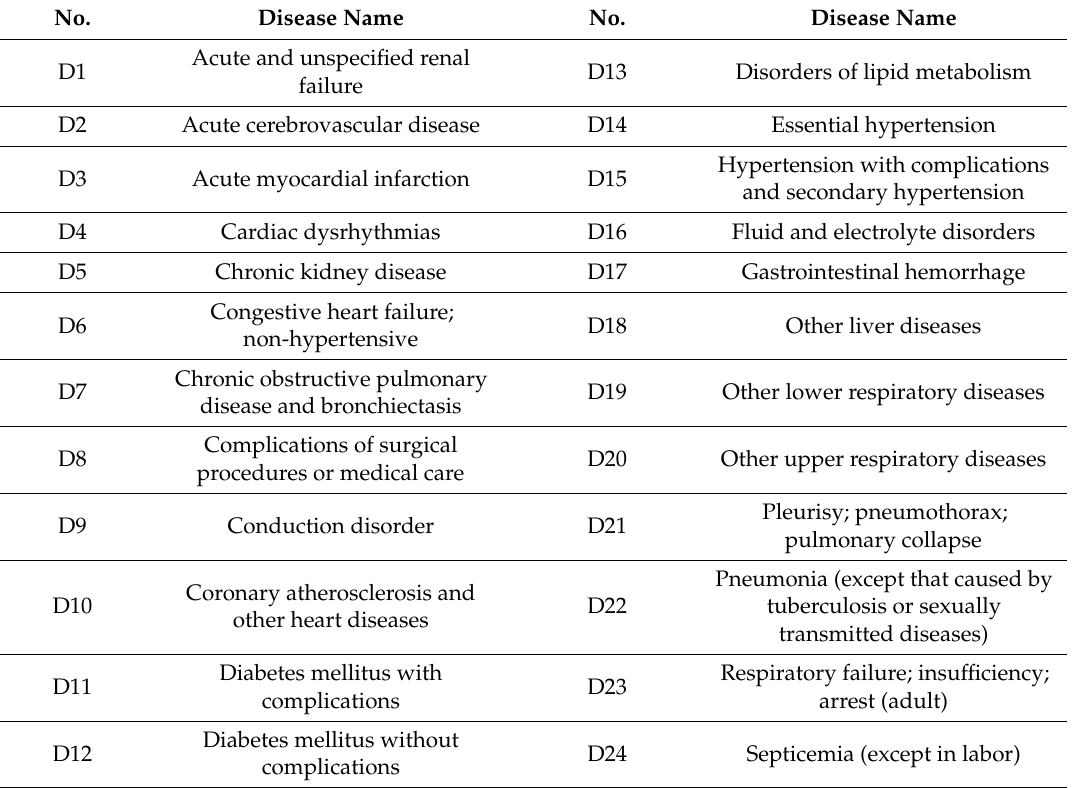
Table 1. The 24 diseases focused on in this study.